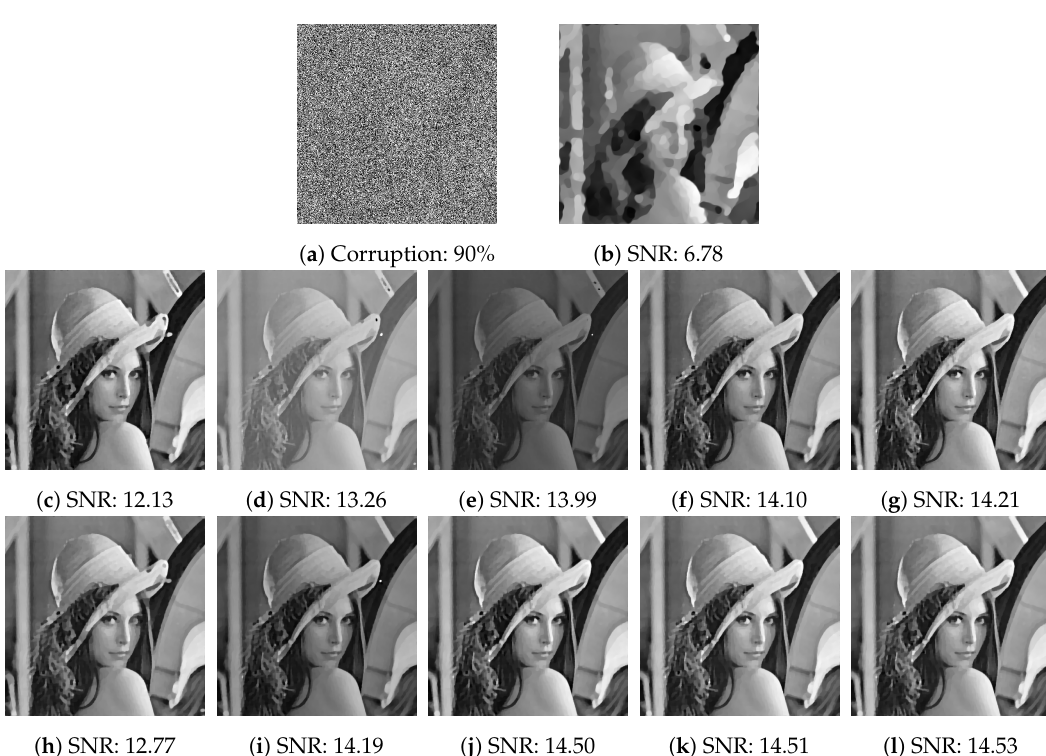
Figure 11. Restored images of TVL1, CTVL1 and HOCTVL1 models on the Lena image corrupted by Gaussian blur and salt-and-pepper noise with noise level 90%. ( a ) Corrupted image. ( b ) TVL1 model. ( c – g ) first correction step to fifth correction step of CTVL1 model. ( h – l ) first correction step to fifth correction step of HOCTVL1